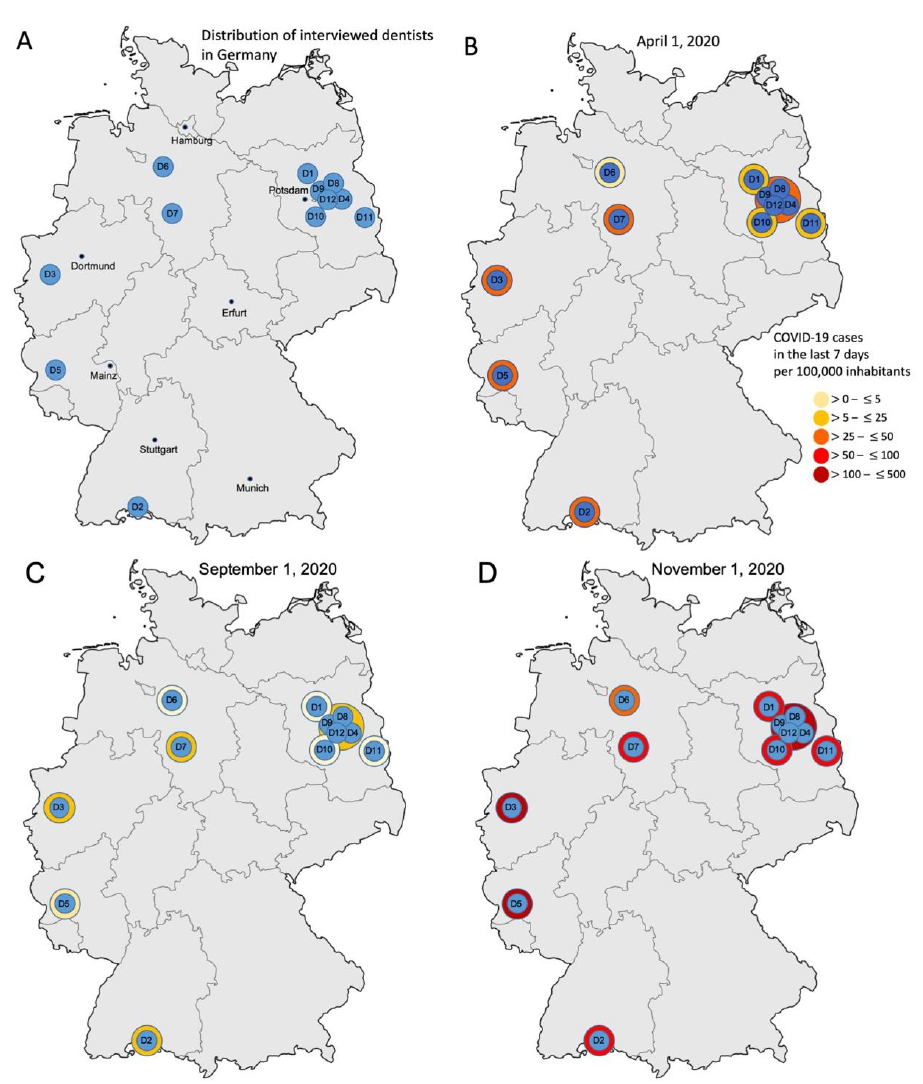
Figure 1. Distribution of interviewed dentists (D1 to D12) in Germany and COVID-19 incidence. ( A ) Distribution of dentists D1–D12. The concrete location of dentists and practices is anonymized, but some German cities are listed by name for orientation. ( B – D ) Incidence rates of COVID-19 at three different time points in 2020 (cumulative cases over the last 7 days per 100,000 inhabitants), according to the official body of the German health surveillance, the Robert Koch Institute (www.rki.de; accessed on 26 January 2021).